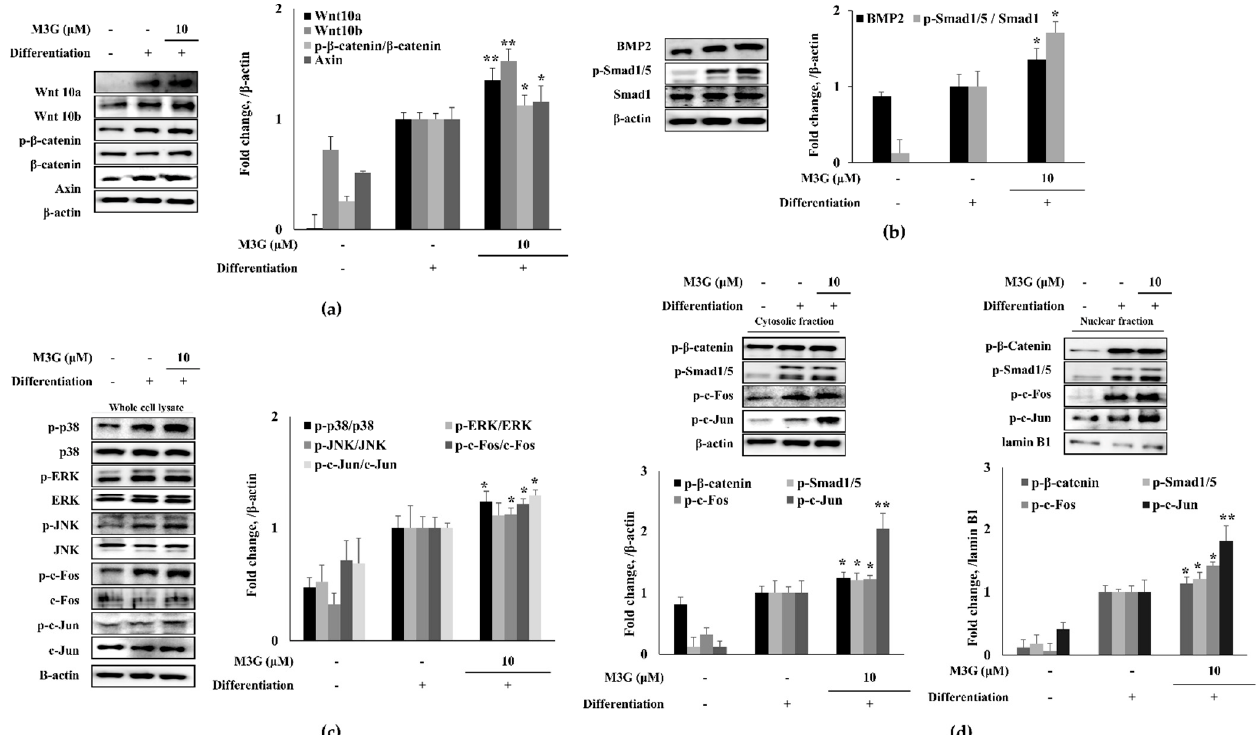
Figure 4. Effect of M3G on Wnt/ β -catenin ( a ), BMP ( b ) and MAPK ( c ) signaling pathways and their downstream nuclear effectors ( d ). Analysis of protein expression was carried out by Western blotting of osteo-induced hBM-MSCs at day 10 differentiation. M3G was treated with initial differentiation induction (3 days) and it was not present in subsequent media changes. β -actin (for whole cell and cytosolic fraction) and lamin B1 (for nuclear fraction) were used as internal loading control. * p < 0.05, ** p < 0.01 vs. differentiated untreated group.